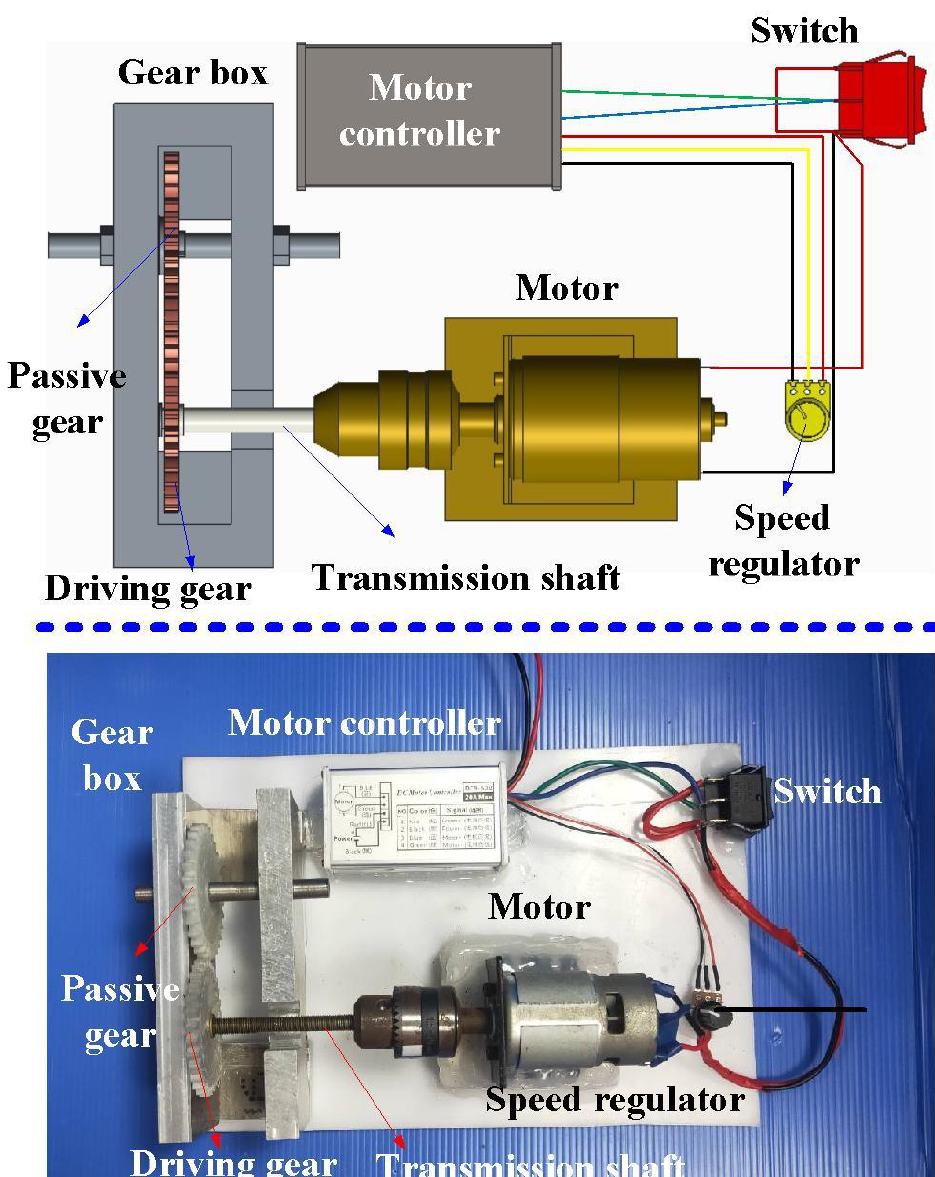
Figure 8. A gear abrasion testing machine developed in this study.